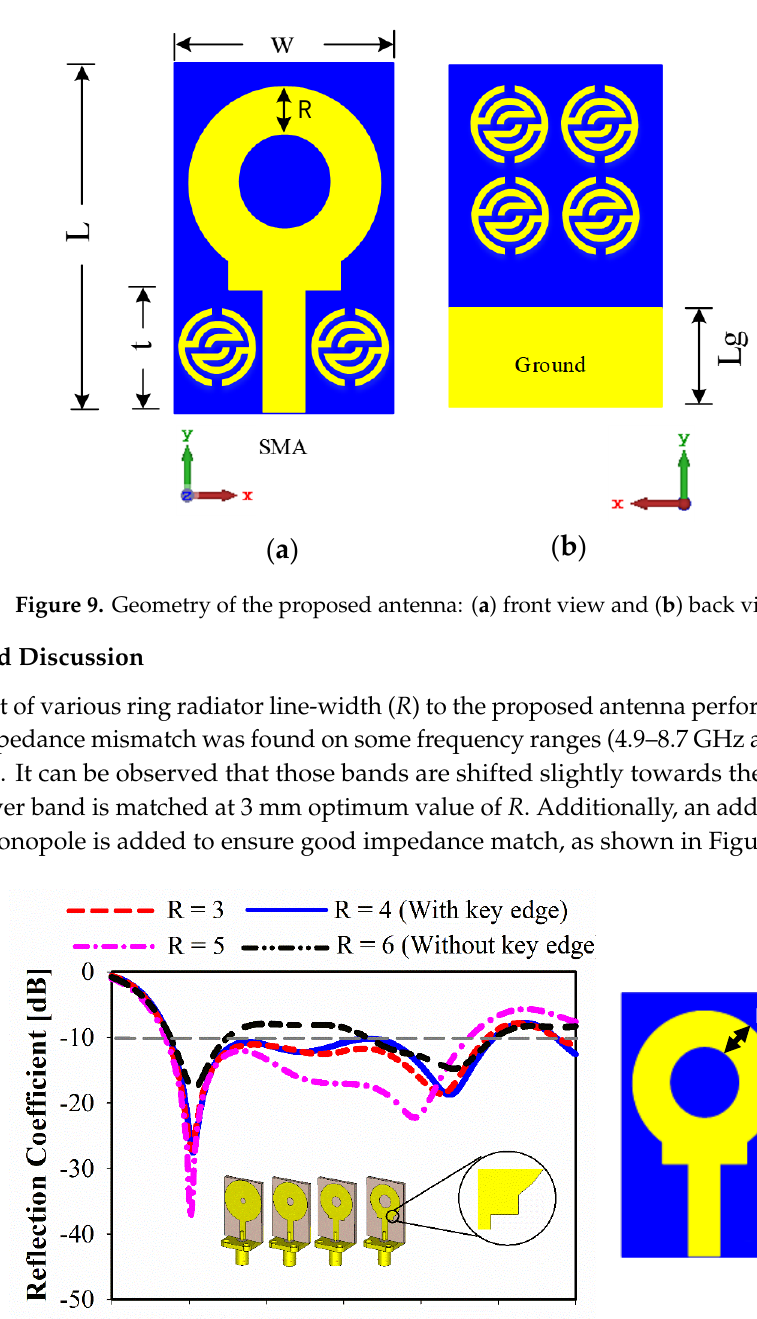
Figure 10. Simulated reflection coefficient for ring radiator line-width R.